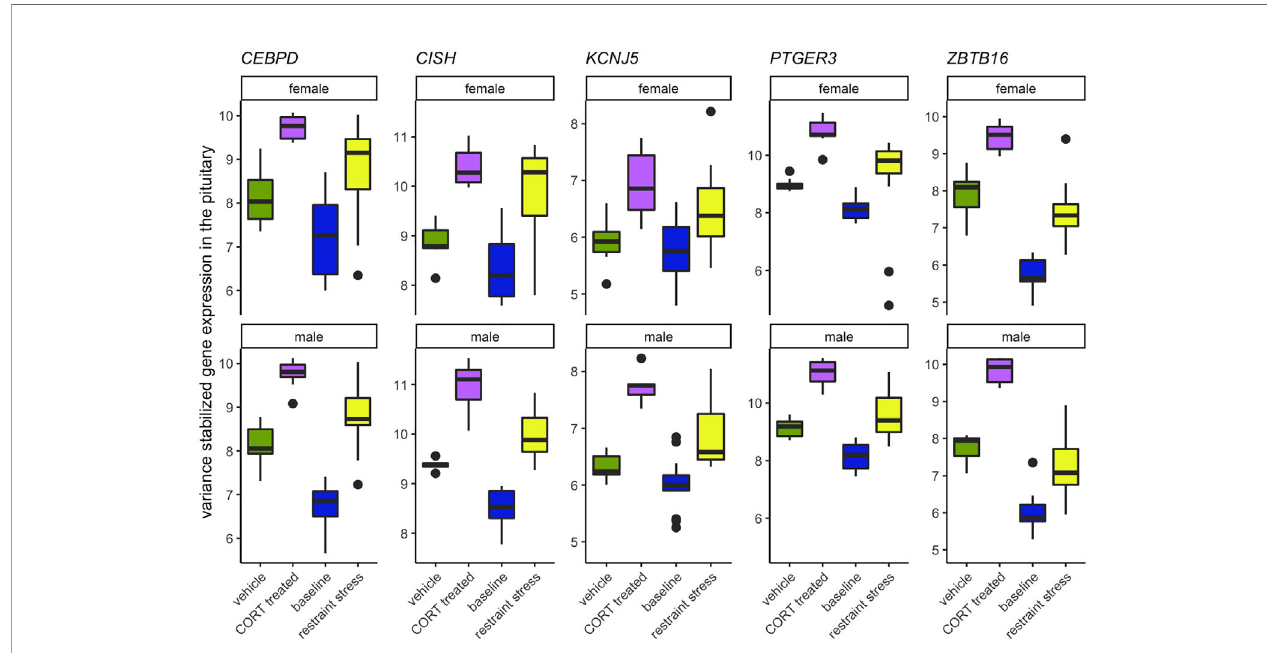
FIGURE 7 | Genes that increase in response to both CORT and stress in both males and females. The elevation of CORT during the stress response resulted in the differential expression in both sexes of KCNJ5 , CISH , PTGER3 , CEBPD , and ZBTB16 in the